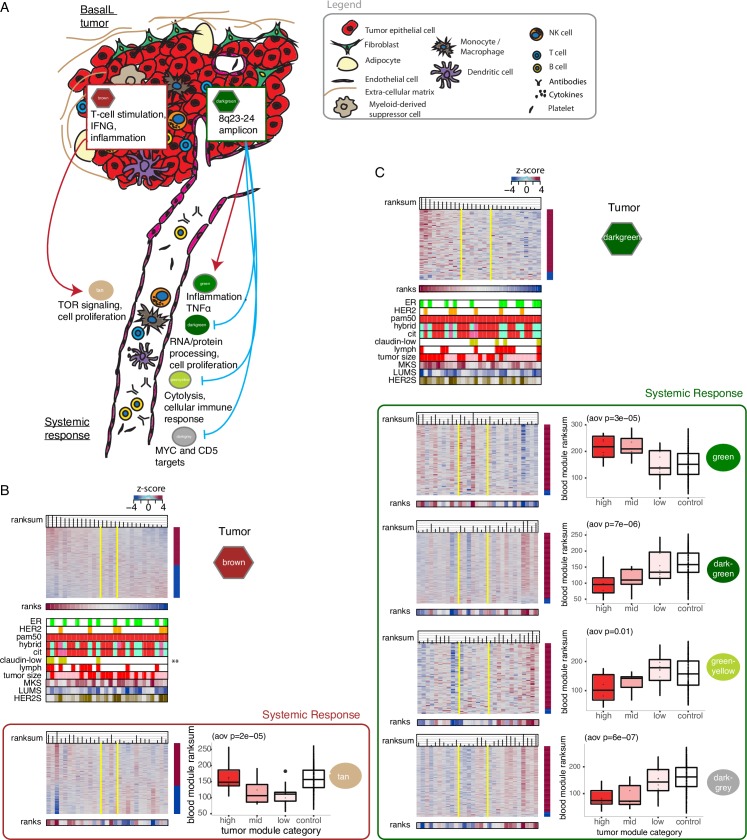
Significant Matched Interactions across Tissue (MIxT) in basalL patients.(A) The figure summarizes the two sets of significant MIxT in basalL patients detailed in Fig 6A and 6C. Top pathway enrichment keywords are presented for each module. Red and blue arrows correspond to negative and positive correlations between ranksums, respectively. (B) MIxT in basalL patients between the brown tumor module and the darkgreen SR module. Heatmaps are ordered by ranksum of gene expression in the brown tumor module. Asterisks represent the level of significance of the associations between the gene ranksums for the brown tumor module and clinicopathological attributes of patients (fdr < **0.05). Associations were estimated using ANOVA and Pearson correlation for categorical and continuous variable, respectively. Boxplots show the distribution of ranksums for the SR module in patients classified according to their ROI95 tumor module category and controls. (C) The second set of MIxT in basalL patients between the darkgreen tumor module and four SR modules (darkgreen, green, greenyellow, darkgrey). Legend follows Fig 6B.